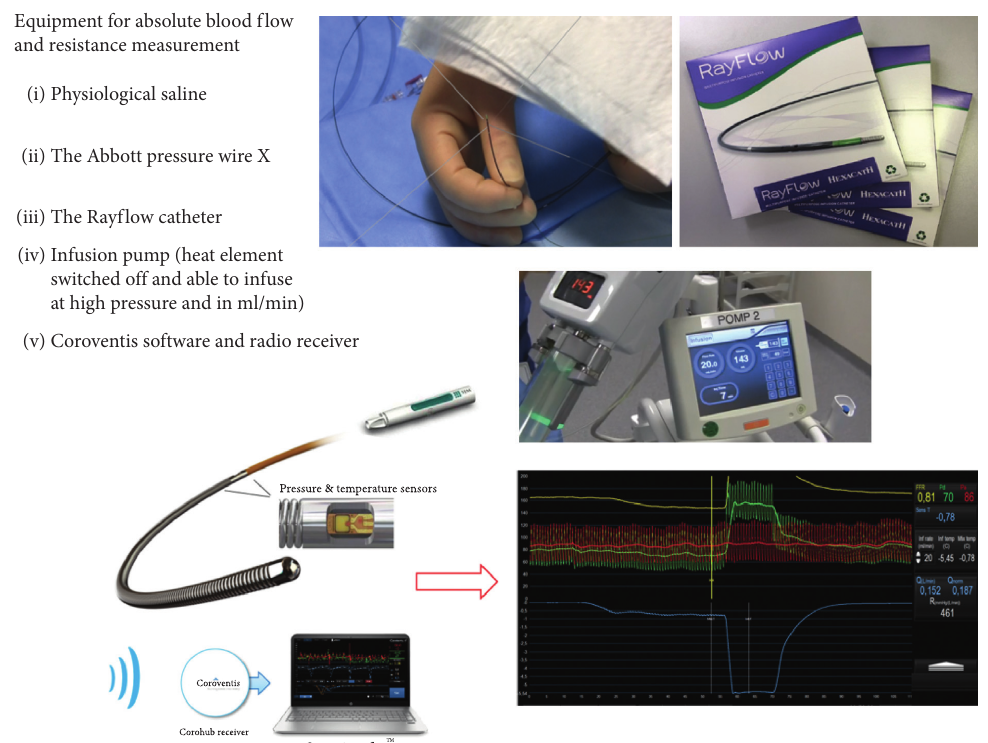
Figure 5: Equipment. All equipment needed for the thermodilution-based assessment of absolute blood flow and resistance is displayed here. The Rayflow catheter is shown in the upper panel, clearly indicating the 4 infusion holes at 0 ° , 90 ° , 180 ° , and 270 ° . The middle panel shows the infusion pump. The lower panel shows the pressure wire with the necessary